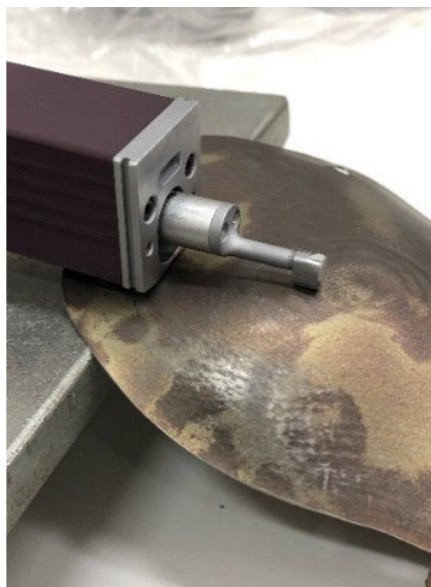
Figure 8. Roughness in the central region of the sample treated at 595º C.